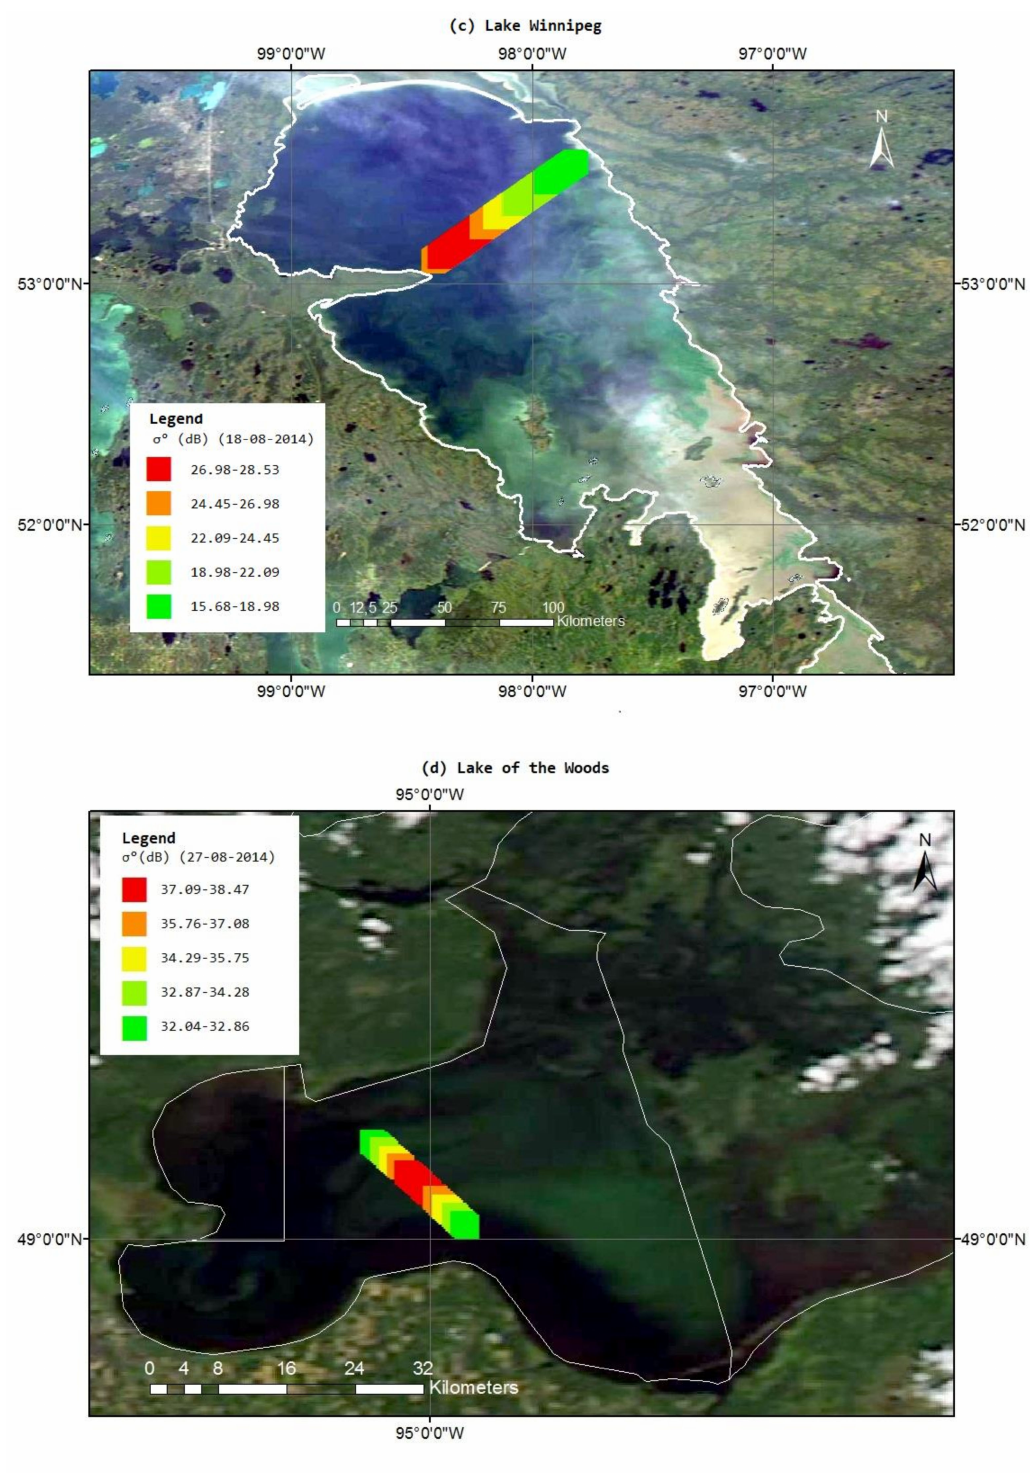
Figure 11. Variations in backscatter (sigma 0) along the Jason-2 tracks over ( a ) Great Slave Lake during cycle 045 (4 August 2014), over ( b ) Lake Athabasca during cycle 095 (27 August 2014), over ( c ) Lake Winnipeg during cycle 195 (18 August 2014), and over ( d ) Lake of the Woods cycle 178 (27 August